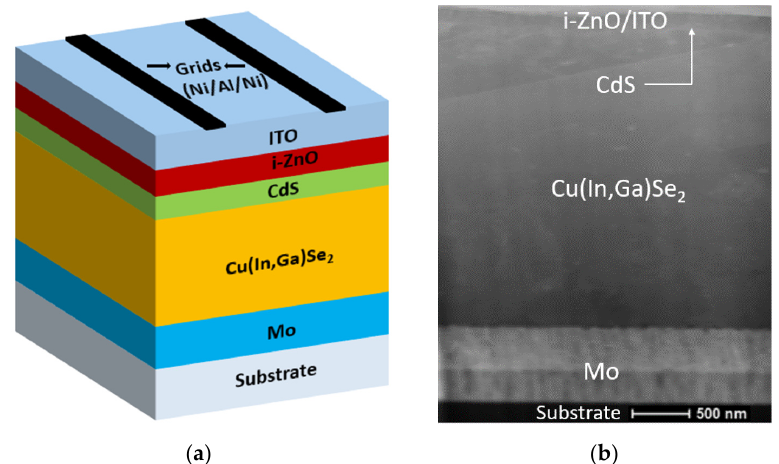
Figure 1. ( a ) Schematic diagram of a typical copper indium gallium diselenide (CIGS) solar cell device. During testing, water arrived from the top. ( b ) STEM-HAADF image of a CIGS reference sample.